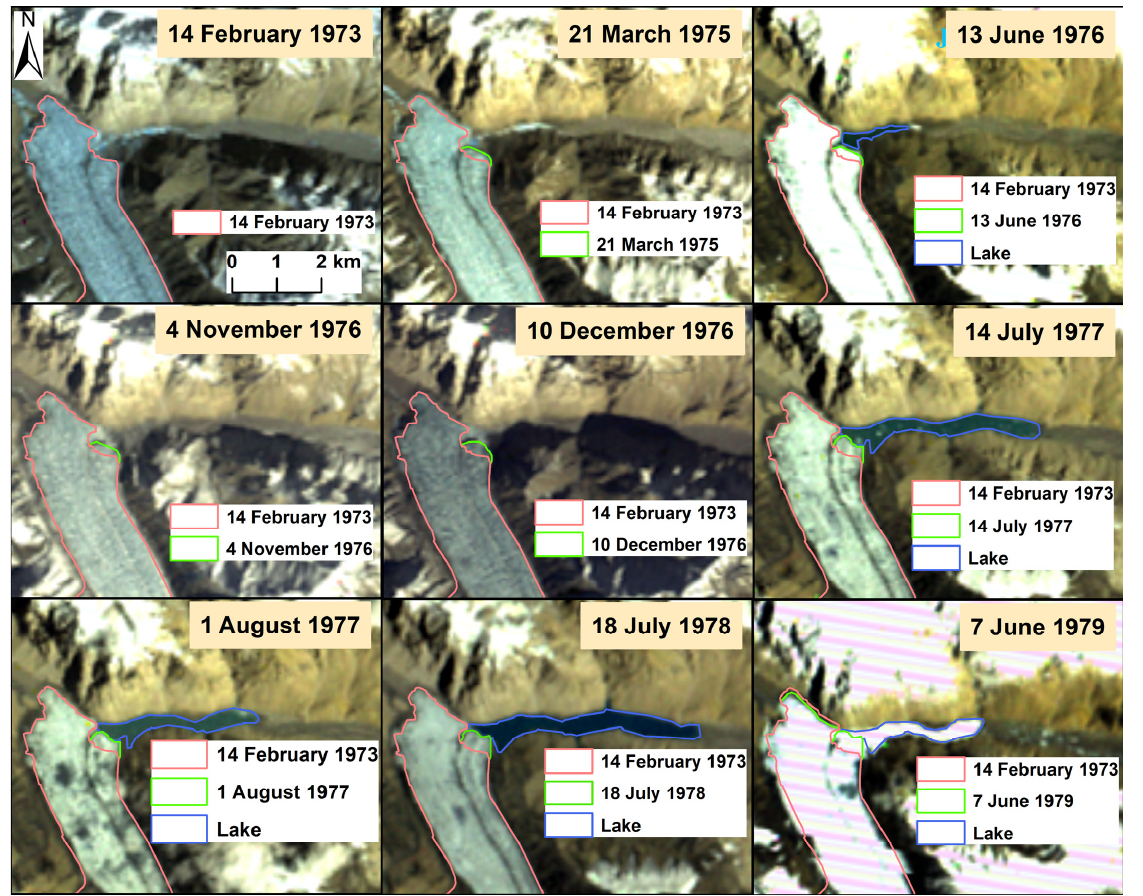
Figure 2. Glacier boundary and glacial lake boundary in different periods from 1975 to 1978.